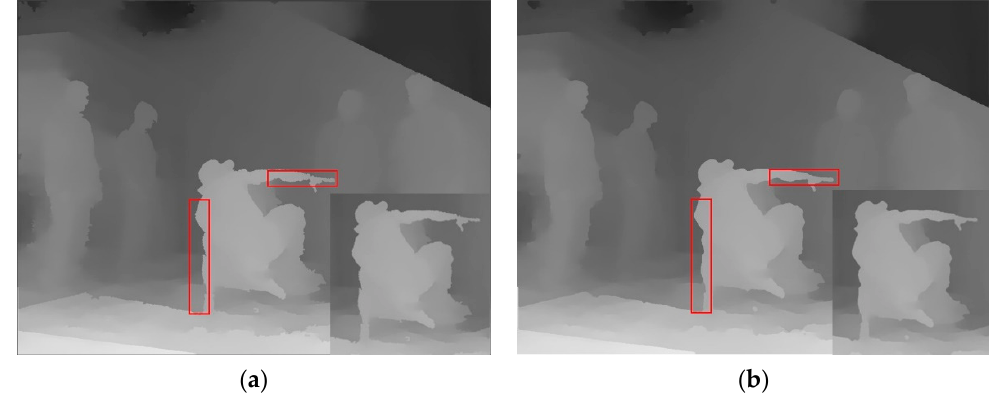
to preprocess the initial